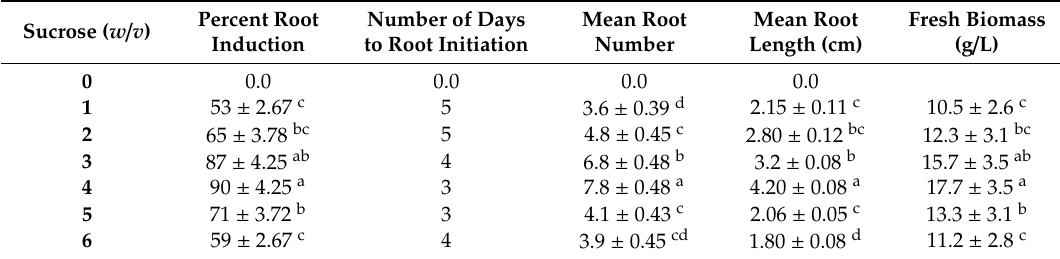
Data represent the mean values of triplicates with ± standard error for each treatment in three repeated experiments. Means sharing the same letter are not significantly di ff erent ( P =